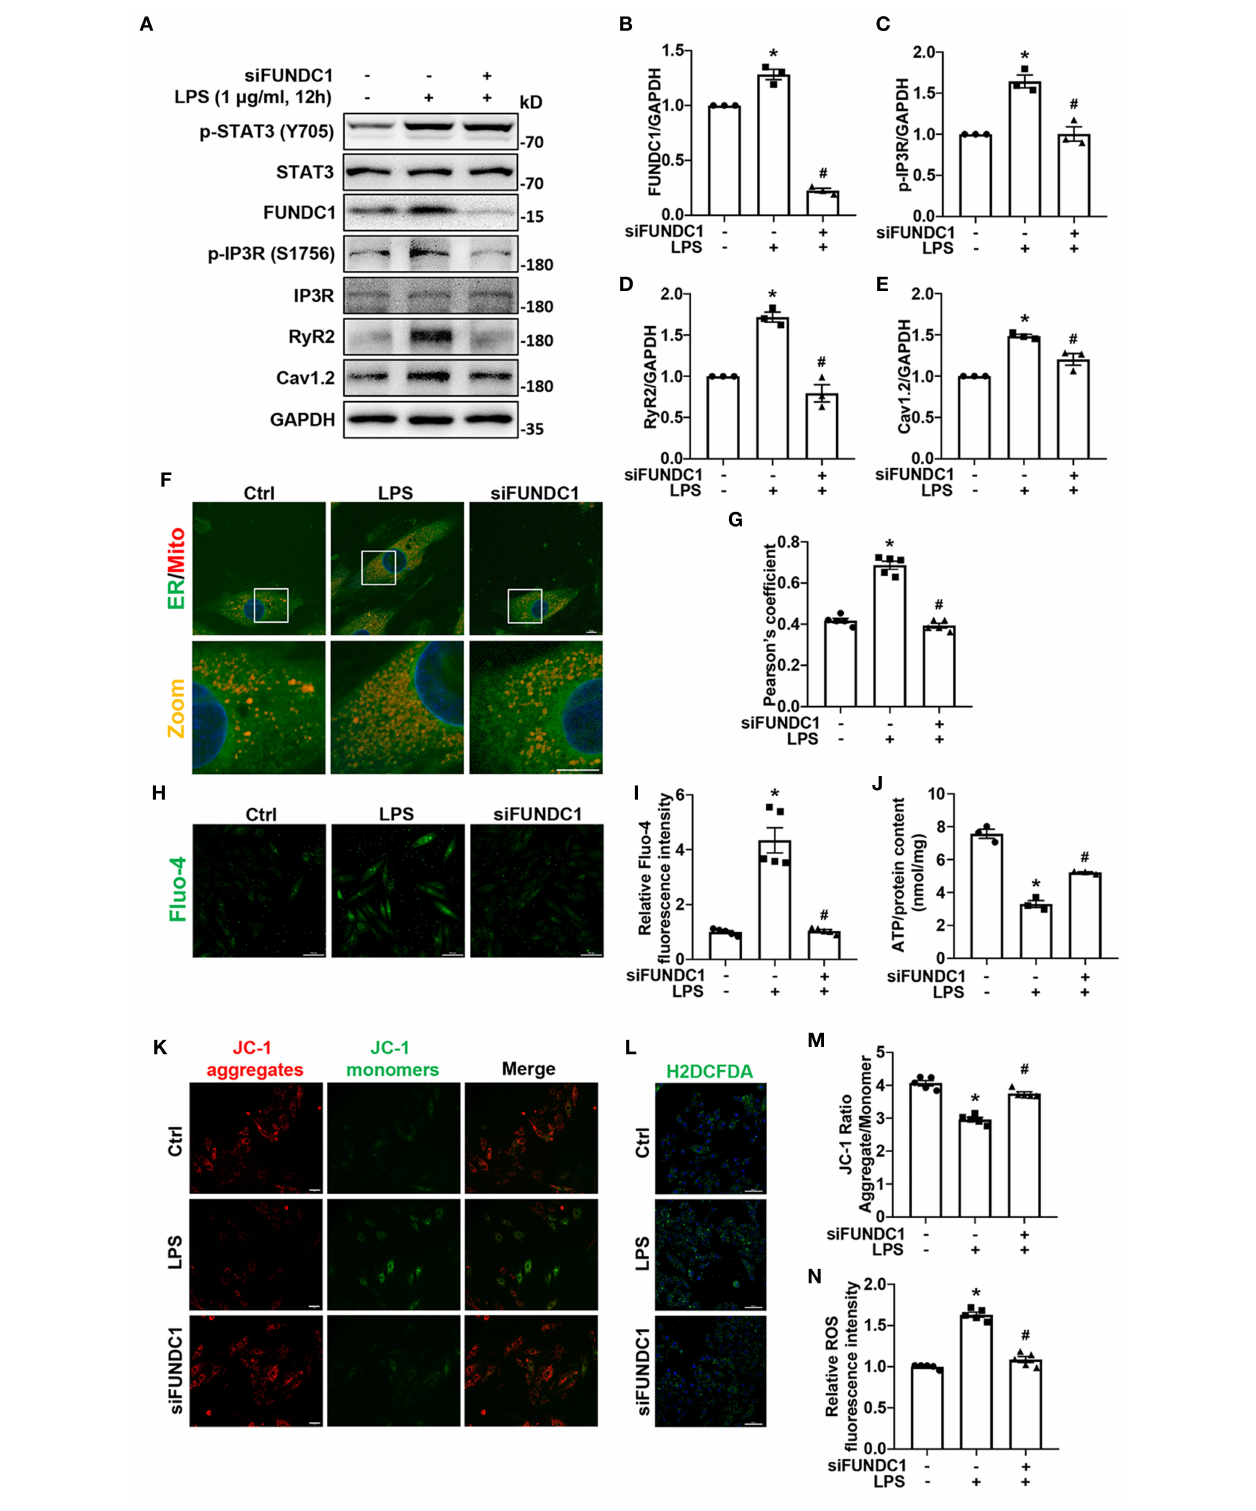
FIGURE 7 | FUNDC1-knockdown prevented LPS-induced calcium signaling-related proteins expression, MAMs formation, increases of intracellular Ca 2 + levels, mitochondrial dysfunction, and ROS production. H9c2 cells were transfected with control siRNA or FUNDC1 siRNA (siFUNDC1), and then treated with LPS (1 µ